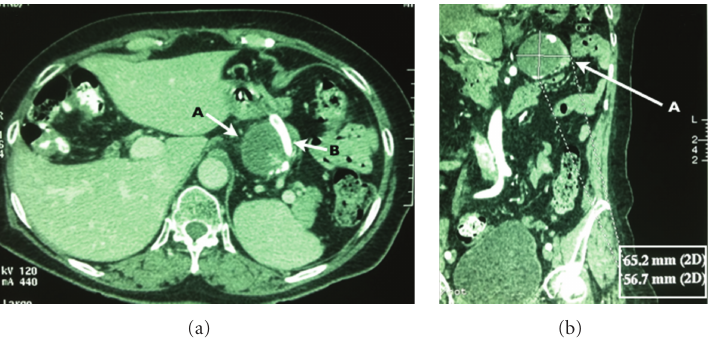
Figure 3: Computed tomography of the abdomen with intravenous contrast (postoperative control). (a) Axial section: A: thrombosed aneurysm sac, B: flow of contrast through the implanted stent. (b) Coronal section: A: thrombosed aneurysm sac, highlighted at the bottom of the figure, the measures of the